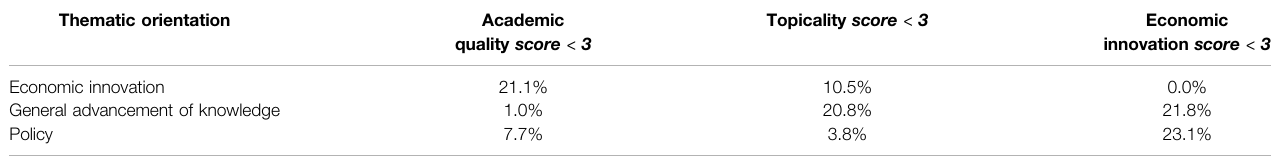
TABLE 3 | Importance of assessment criteria (score < 3) by formal orientation of the instrument. Note: NL instruments and 1 DE instrument have some missing data on assessment criteria. Thematic